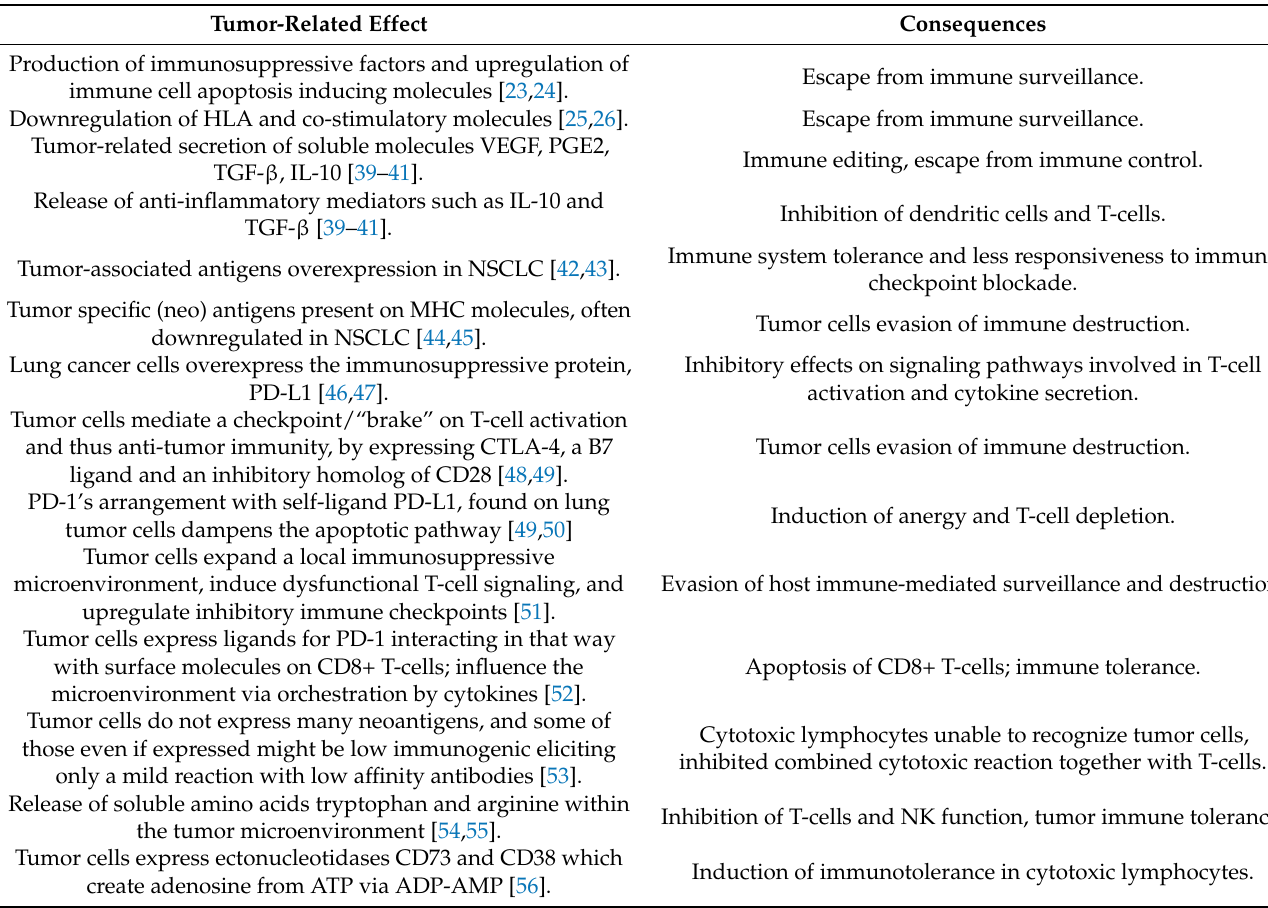
Table 1. Tumor-related immunosuppressive